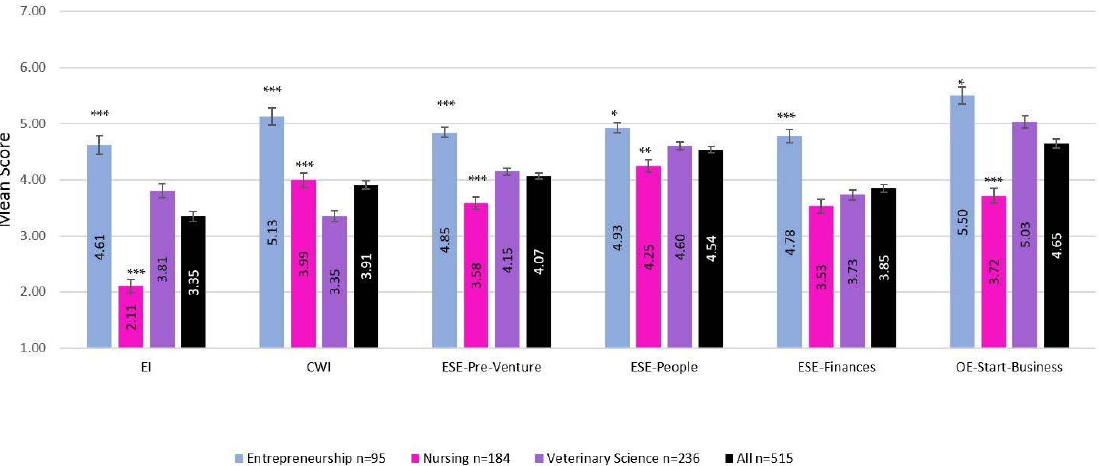
Figure 1. Mean scores (with standard error bars) of entrepreneurial intention (EI), intention to work in large (corporate) organizations (CWI), entrepreneurial self ‐ efficacies (ESE) (pre ‐ venture,